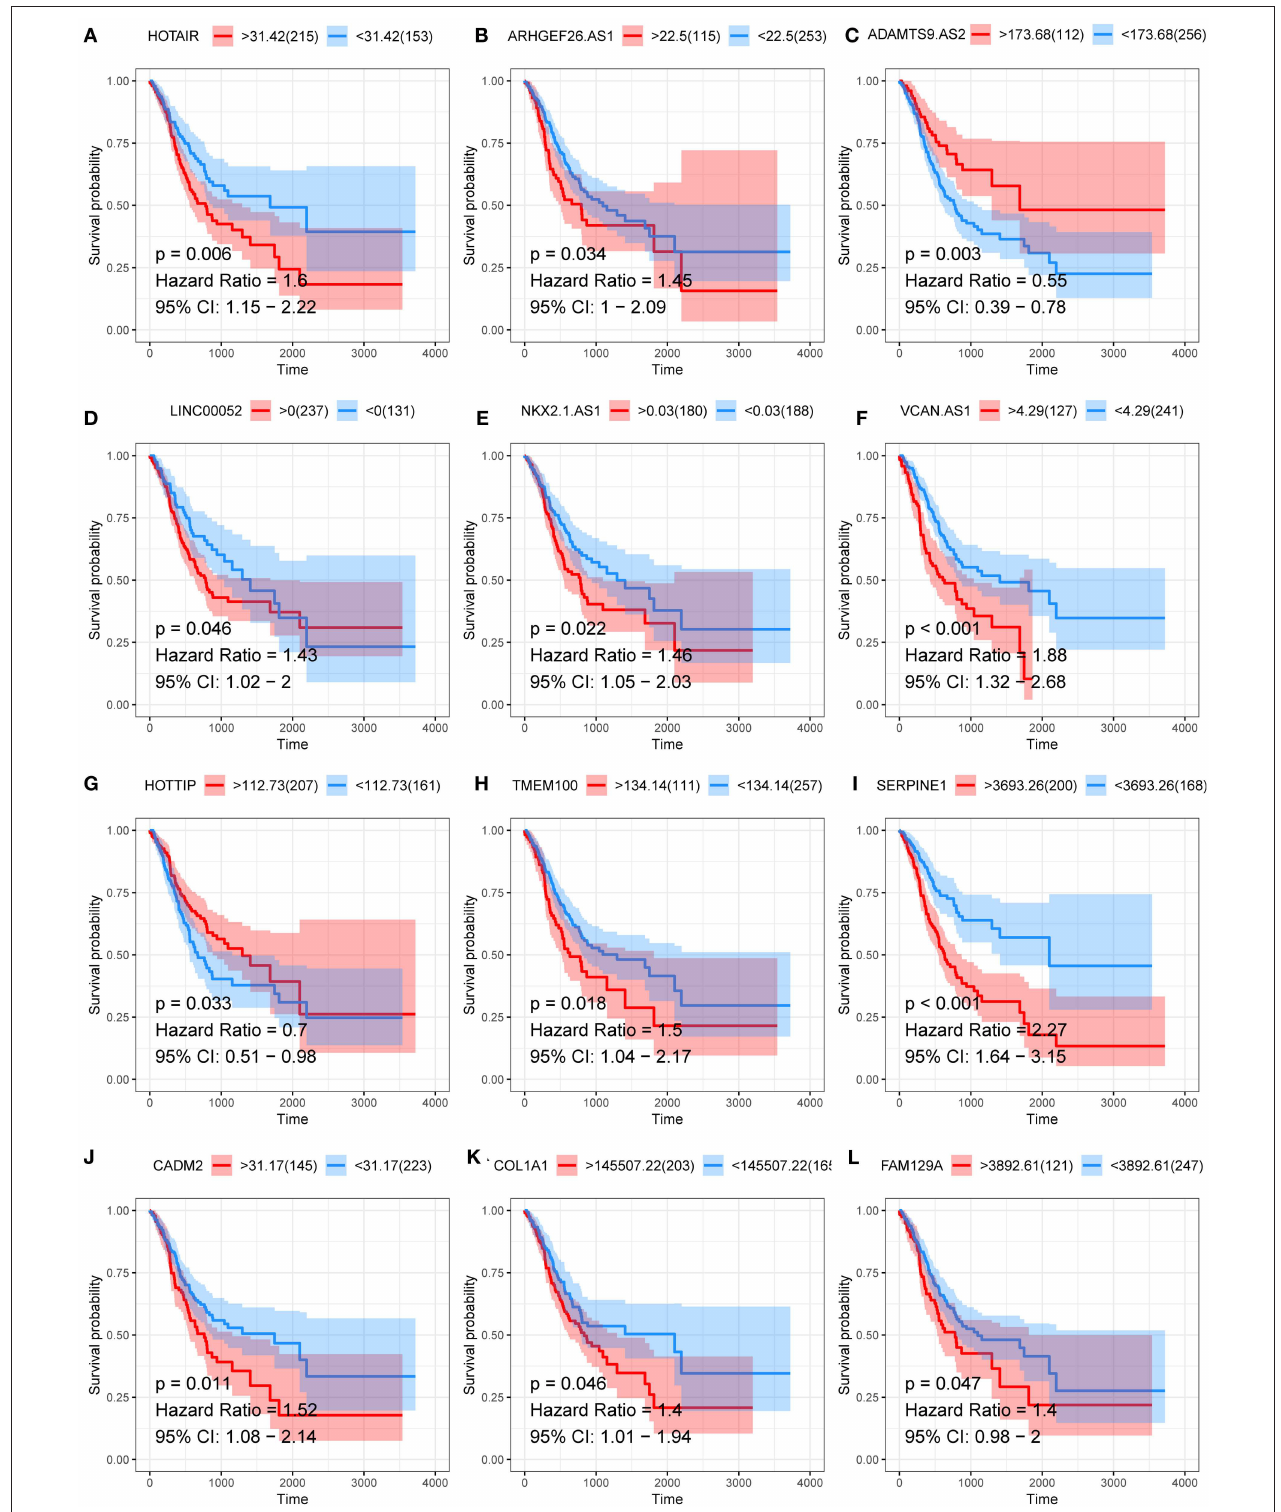
FIGURE 4 | Kaplan–Meier curve of lncRNAs (A–G) and mRNA (H–L) that significantly correlated with overall survival.